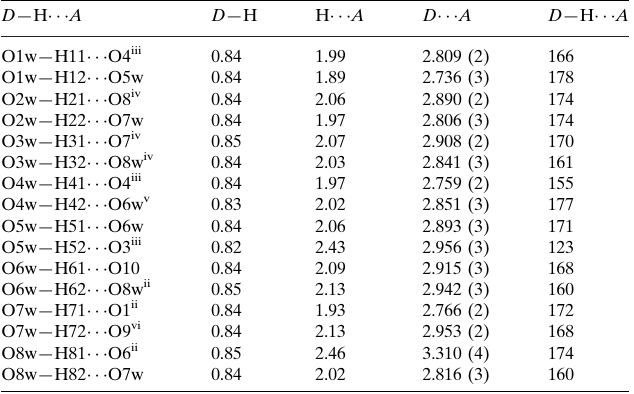
Hydrogen-bond geometry (A˚ , (cid:3)